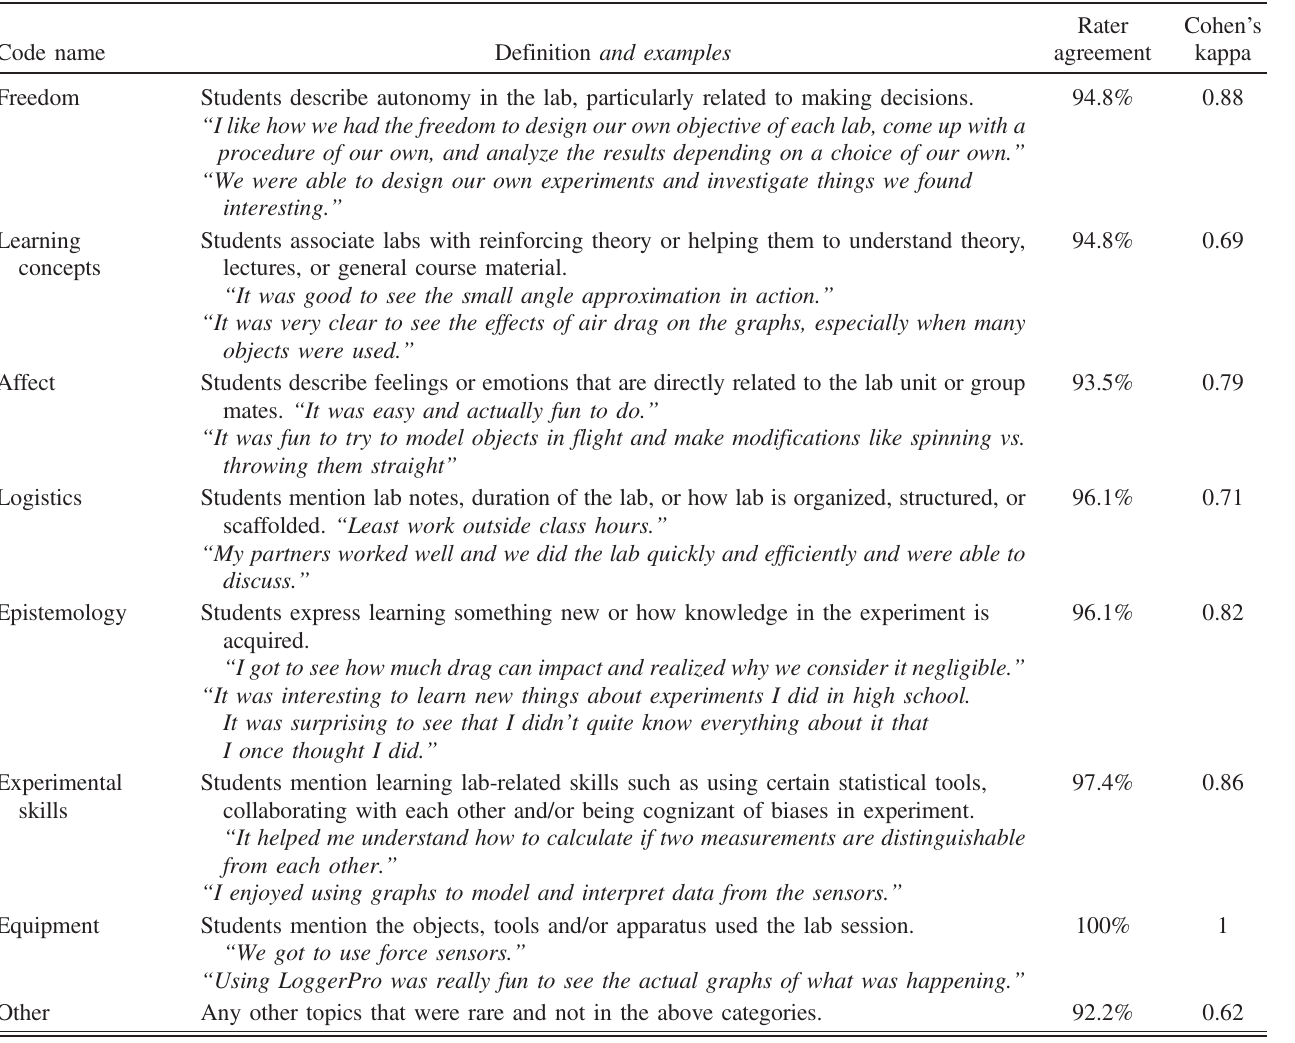
TABLE III. The codebook for students ’ reasoning for their favorite lab unit with code names and their definition. Percent agreement and Cohen ’ s kappa values are also given as an interreliability measure between the